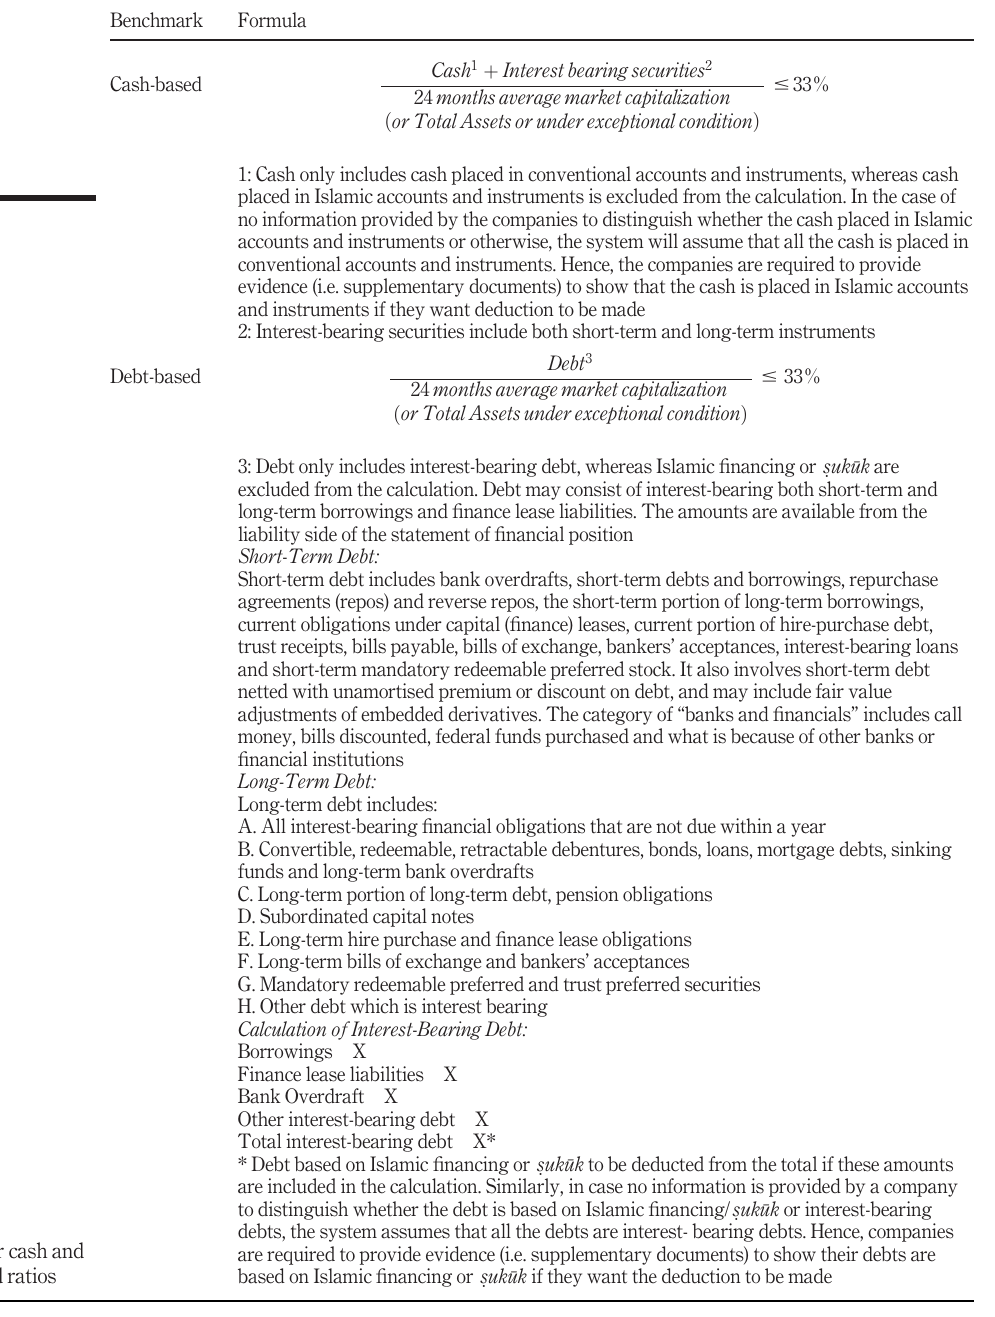
Table II. Criteria for cash